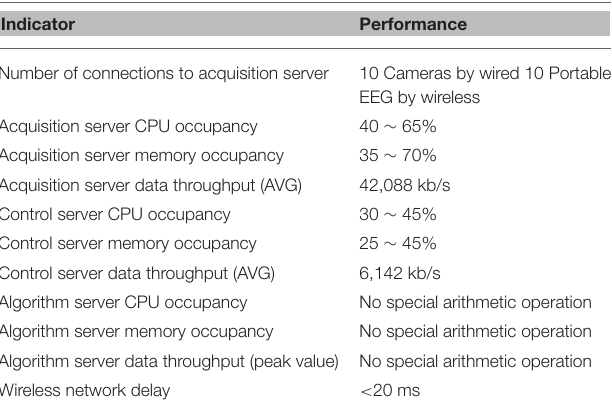
FIGURE 11 | Real-time visualization during the experiment. TABLE 4 | The main operation results of system